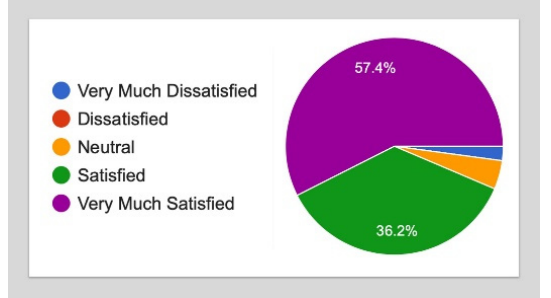
Buildings 2022 , 12 , x FOR PEER REVIEW Figure 6. Satisfaction of students with the event. Figure 6. Satisfaction of students with the event.